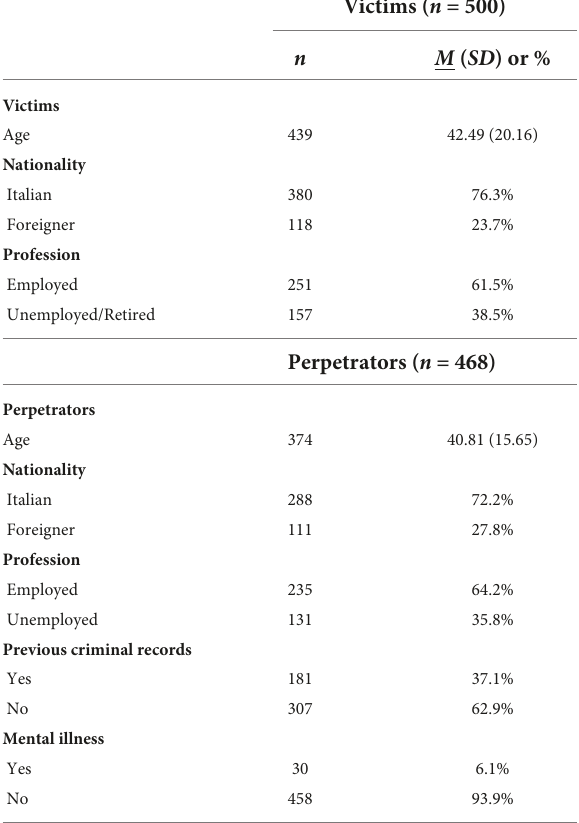
TABLE 2 Sample: Socio-demographic description of victims and